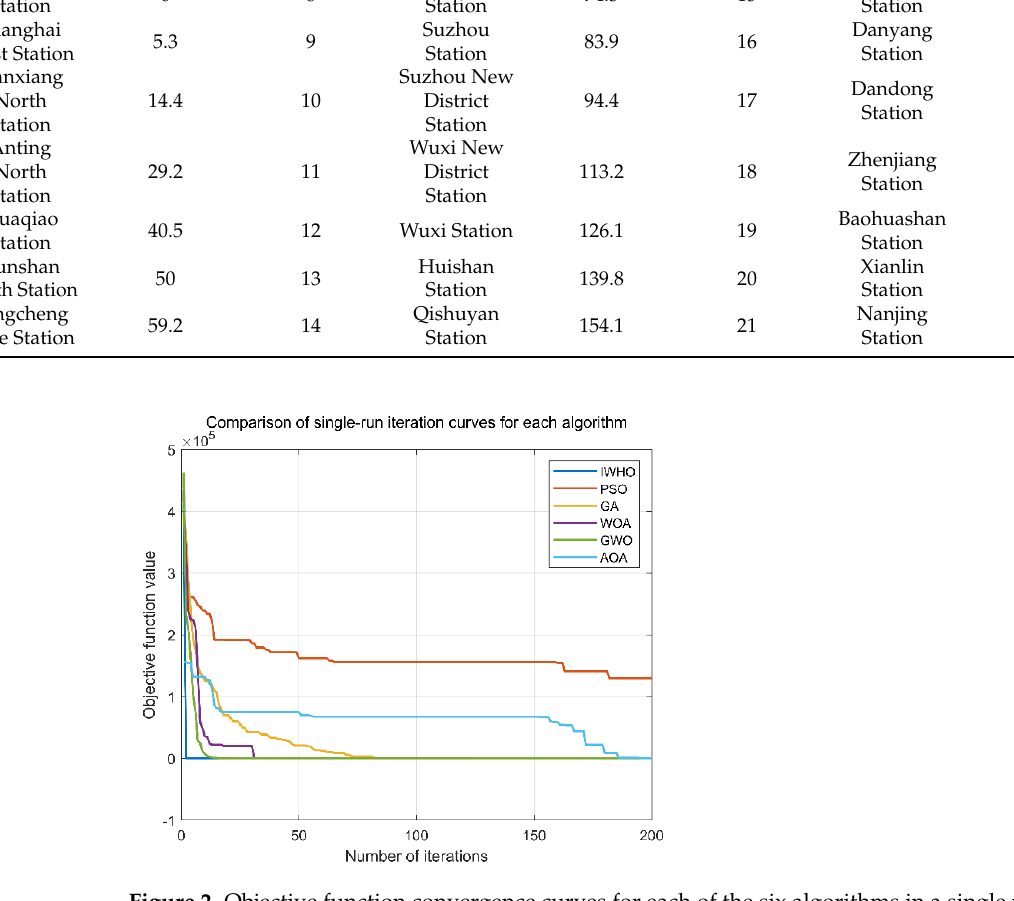
Figure 2. Objective function convergence curves for each of the six algorithms in a single run.